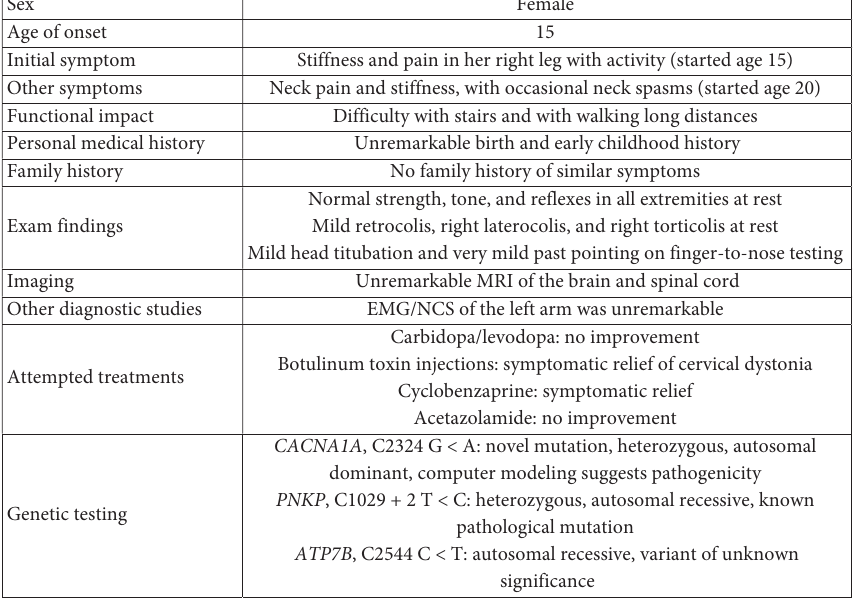
Figure 1: Clinical characteristics and genetic